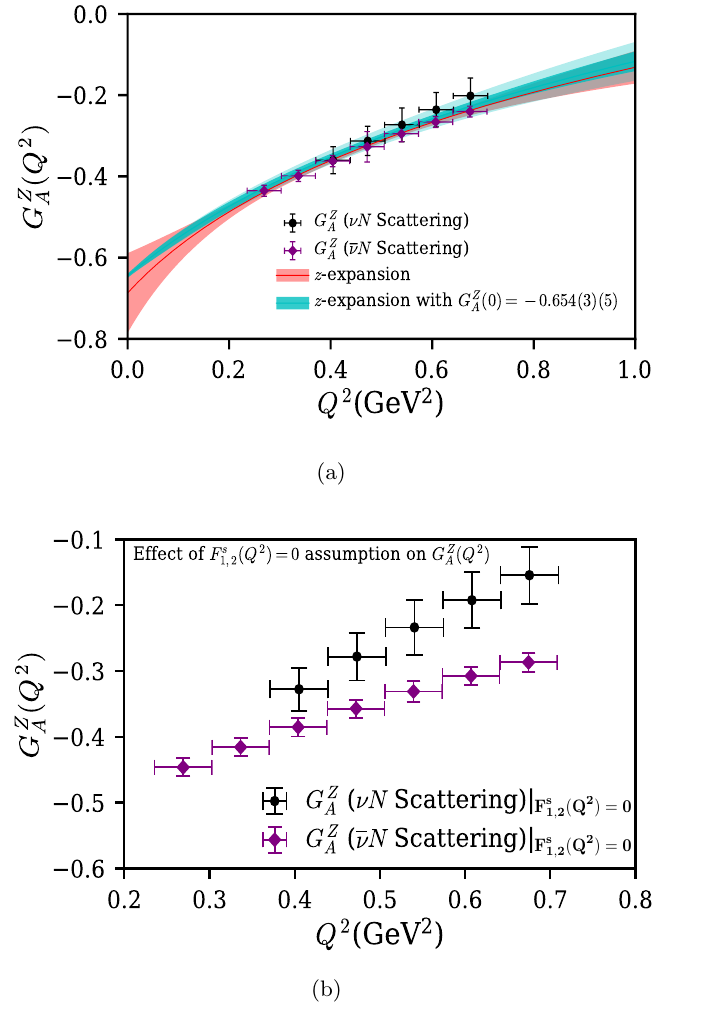
Figure 1 . (a) Neutral current weak axial form factor G Z ( Q 2 ) obtained from analyses combining A MiniBooNE data of ( (cid:23) ) (cid:23) (cid:0) N scattering di(cid:11)erential cross sections, lattice QCD estimates of strange quark electromagnetic form factors, strange quark axial charge and a model-independent (cid:12)t of the nucleon electromagnetic form factors experimental data used from ref. [70]. The red band shows 4-term z -expansion (cid:12)t to the G Z ( Q 2 ) data where the systematics coming from 2-terms, 3-terms A z -expansion (cid:12)t are added in quadrature to the statistical uncertainty of the 4-term (cid:12)t. The cyan band shows the z -expansion (cid:12)t to the G Z ( Q 2 ) data when G s (0) is (cid:12)xed by the value in eq. (2.3). A A The outer cyan band indicates an estimate of additional systematic uncertainty from the strange quark electromagnetic form factors calculated in other lattice QCD calculations [65{67] discussed in the text. (b) Neutral current weak axial form factor G Z ( Q 2 ) by assuming zero strange quark A electromagnetic form factor, i.e. F s ( Q 2 ) = 0. An assumption of F s ( Q 2 ) = 0 leads to di(cid:11)erent 1 ; 2 1 ; 2 values of neutral current weak axial form factor of the nucleon at the same Q 2 , obtained from (cid:23) (cid:0) N and (cid:23) (cid:0) N neutral current scattering di(cid:11)erential cross sections data in refs. [22, 23].